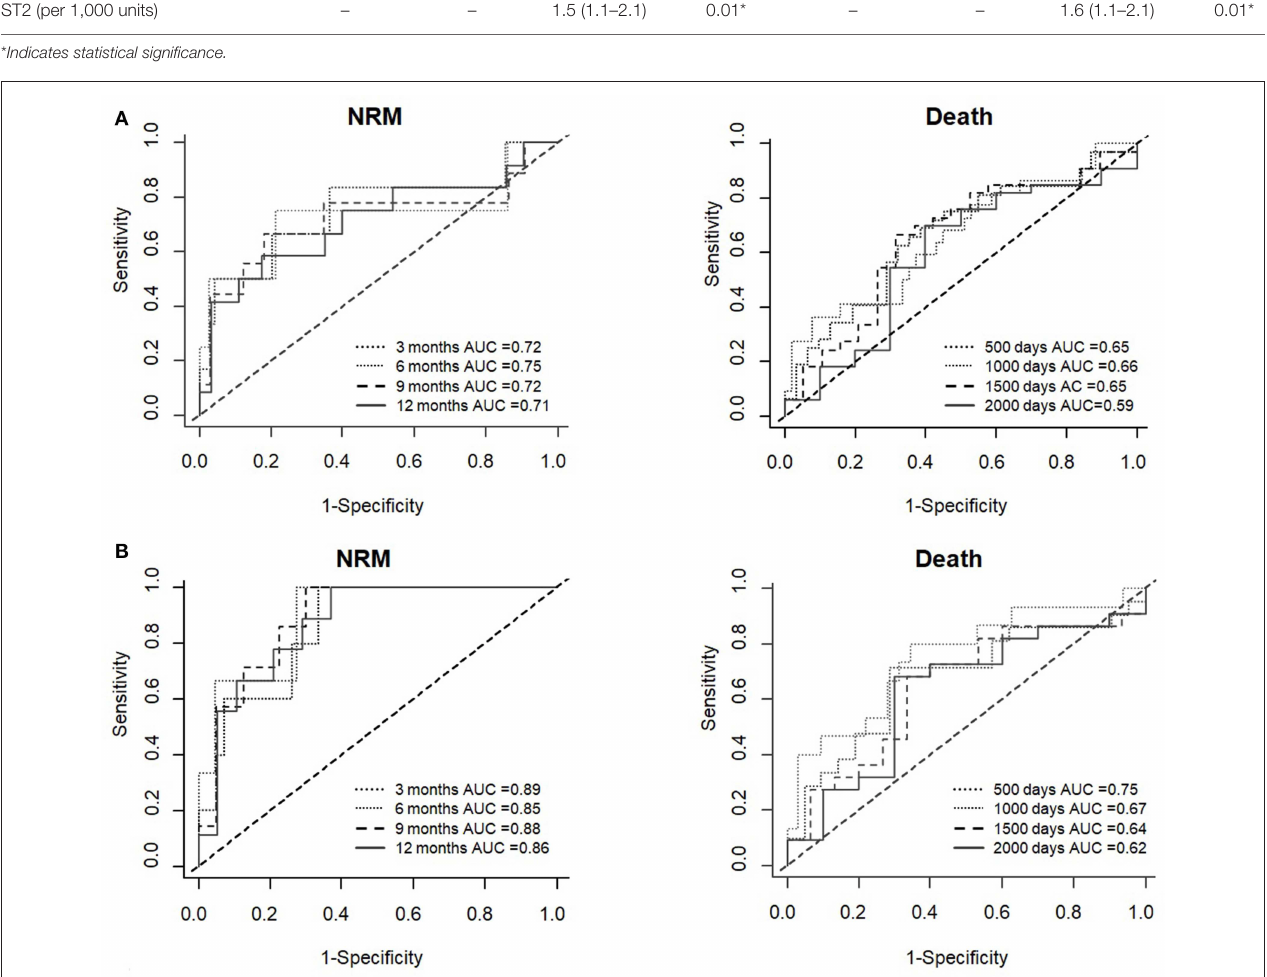
FIGURE 2 | Time-dependent ROC curves for NRM and death using ST2 levels at day + 30 in both, the whole cohort (A) and the RIC cohort (B) .